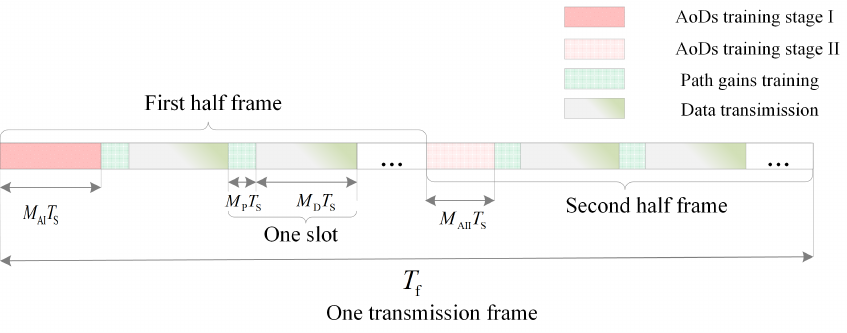
Figure 1. Downlink transmission frame structure consisting of AoD training, path gains training and data